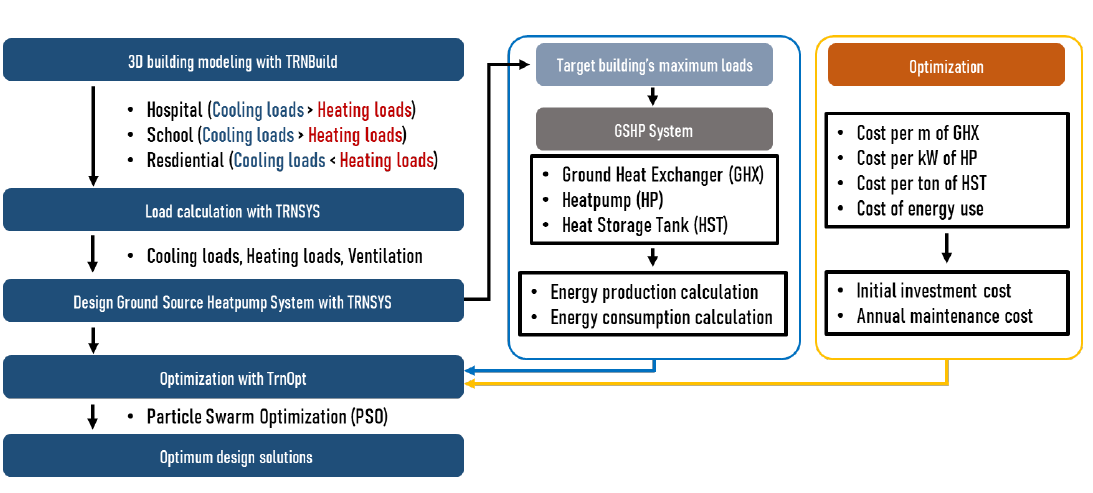
Figure 3. Study flow chart.